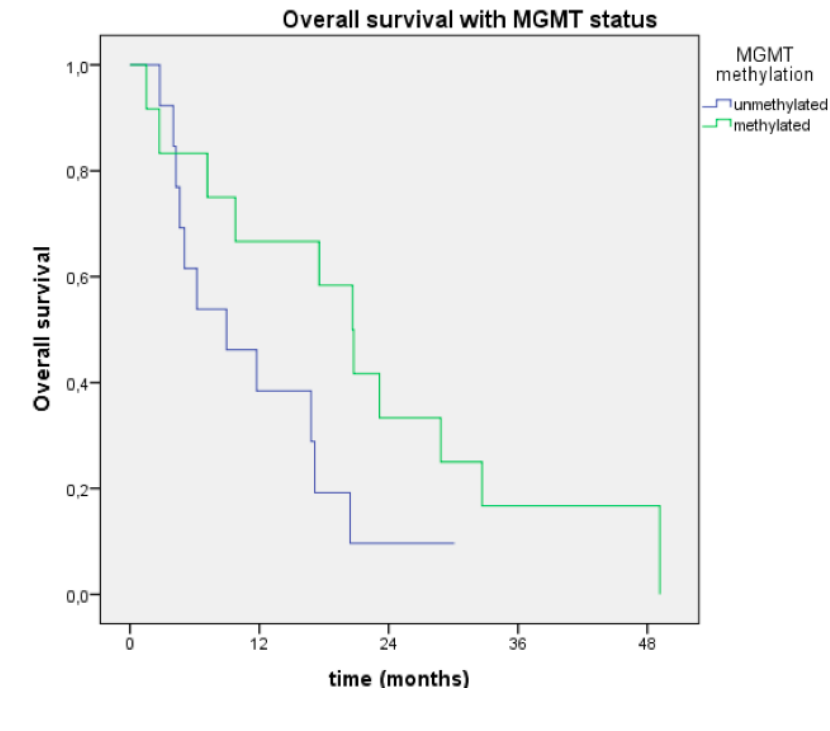
Figure 4. Overall survival curves of patients with methylated or unmethylated